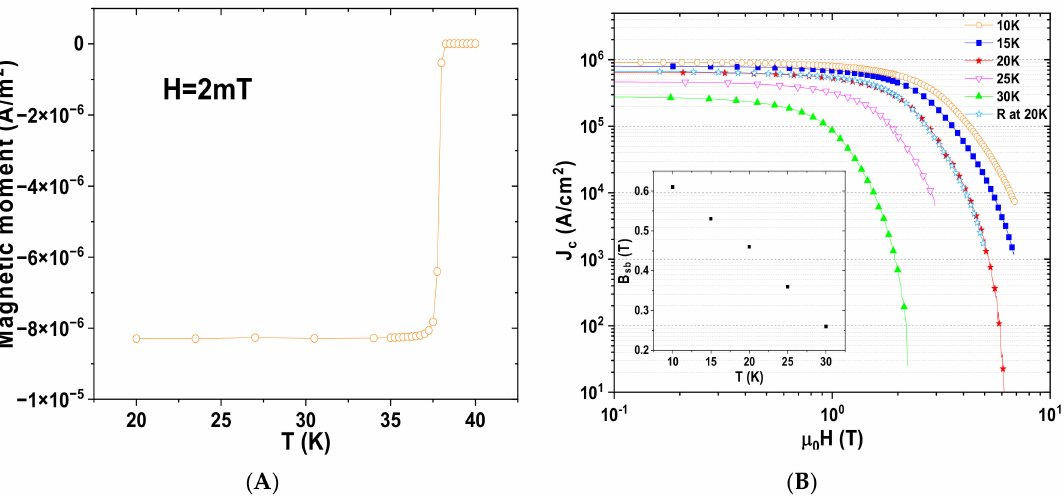
Figure 3. ( A ) Magnetic moment of sample A as a function of the temperature. ( B ) Magnetic field dependence of the critical current density J c of sample A at various temperatures. The figure also shows J c for sample R at 20 K (blue stars). The inset shows the crossover field B sb as a function of